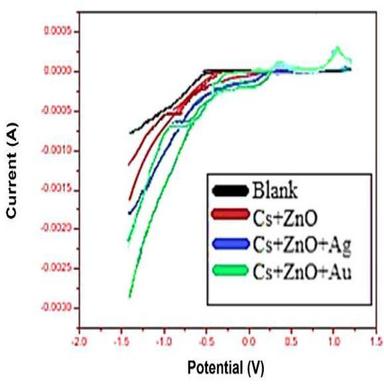
Cyclic voltammograms of Ti surfaces in solution for Hanks.v(A) Naked Ti; (b) ZnONPs; (c) ZnOs; (d) ZnOs; (d) AuNPs;Velocity: 50 mV.s−1